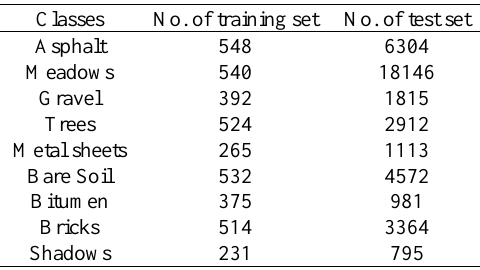
Table 3. The training and test